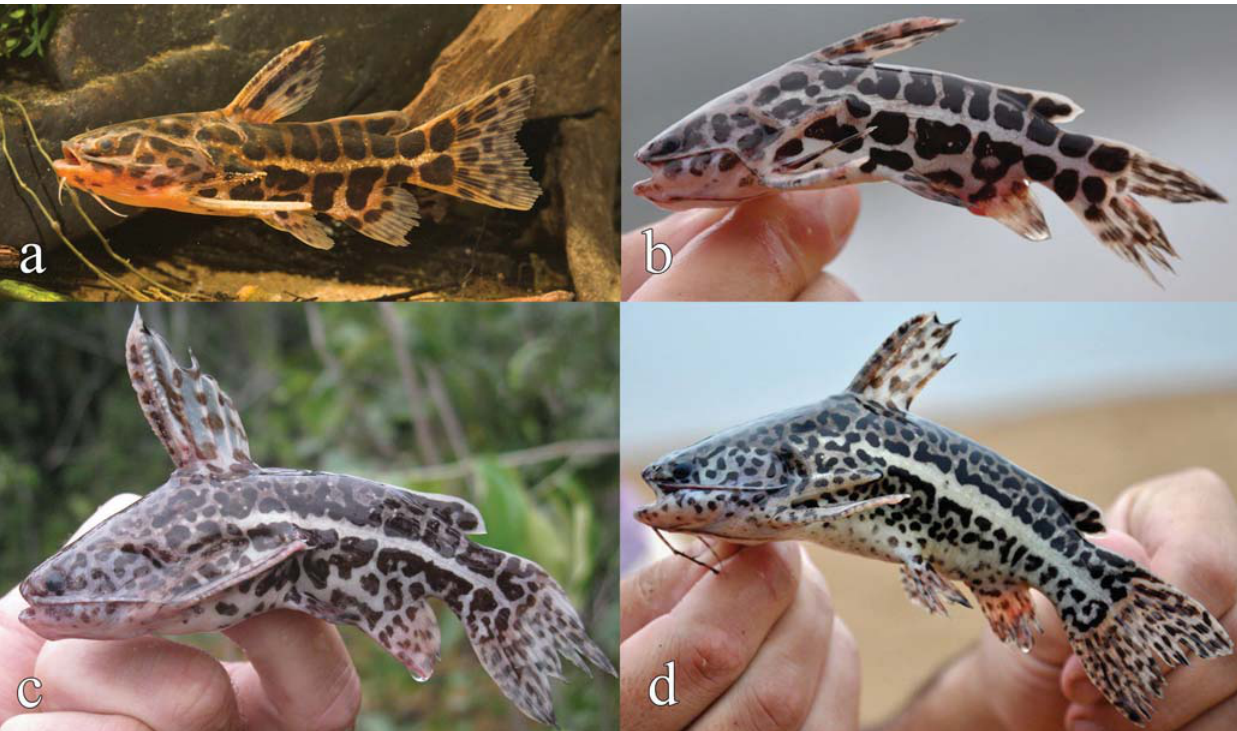
Fig. 2. Liosomadoras oncinus : ( a ) specimen purchased on the Aquarium trade in Montreal (photo by Oliver Lucanus); ( b ) and ( d ) AUM uncatalogued, collected with MZUSP 105828 (photo by Nathan Lujan); ( c ) MZUSP 105828 (nuptial male), río Ventuari, Orinoco basin. All photographed